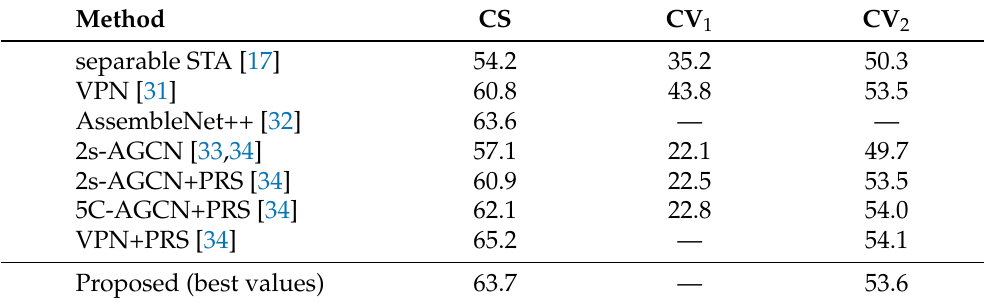
Table 3. Comparison to state-of-the-art methods. Mean per-class accuracy (in %).